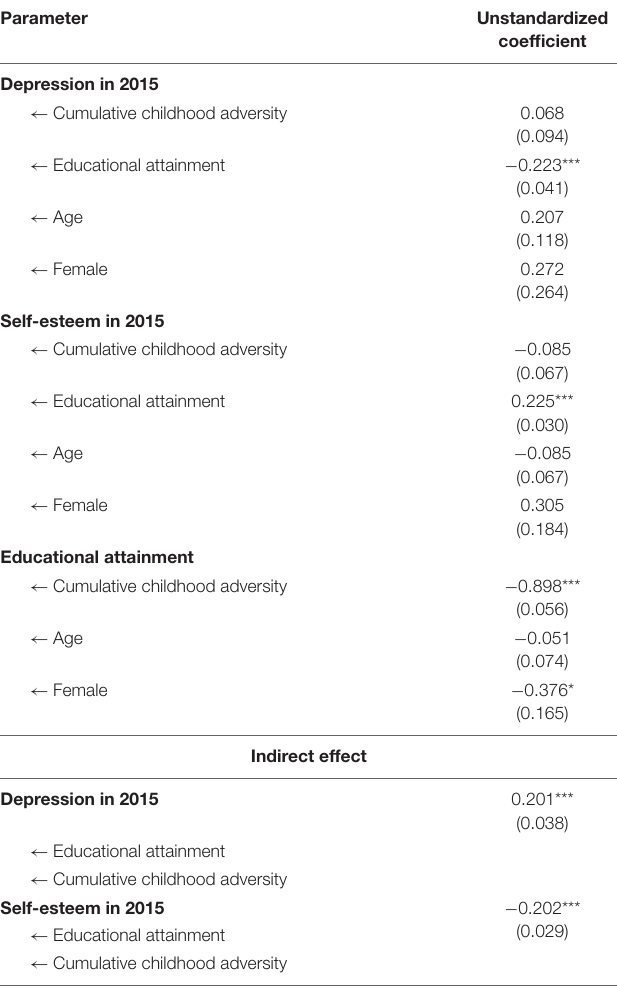
Parameter Unstandardized